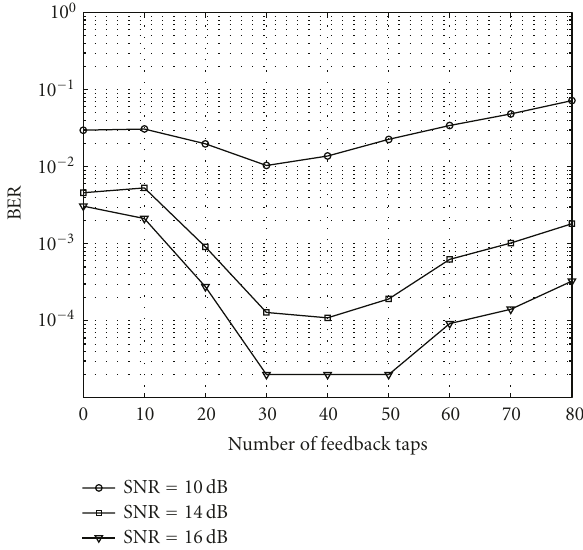
Figure 7: BER plot for time-variant channel with uncorrelated fading on each tap. The solid line represents DFE-Turbo BICM and dashed line represents DFE-BICM-ID.